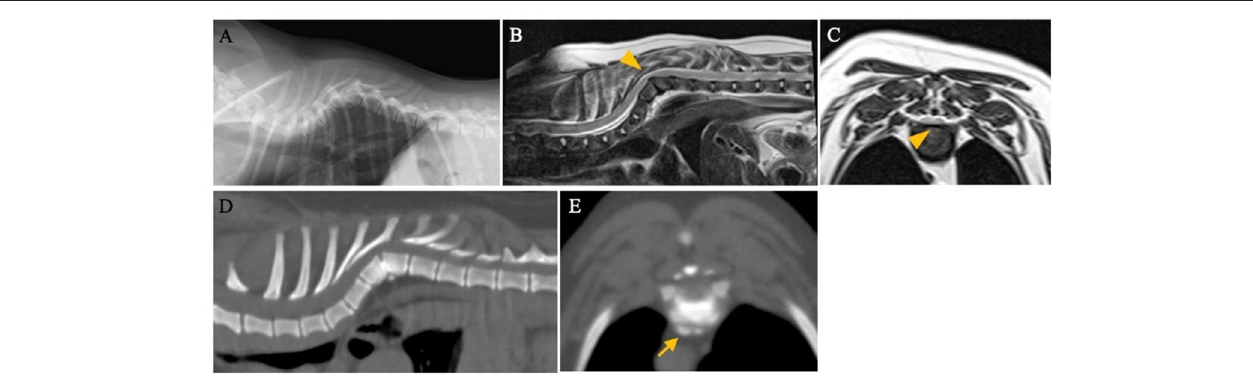
FIGURE 1 | Radiographic, computed tomography (CT), and magnetic resonance images of a 2-year-old dog with wobbly gait of the pelvic limbs. (A) Left-right lateral view. There was ventral hypoplasia of T6 and T7 with severe kyphosis. T2-weighted sagittal (B) and transverse (C) magnetic resonance images at the T6–T7 level. The spinal cord was severely compressed by the deformed vertebrae (arrowhead). (D,E) CT images showed sclerotic changes at the vertebral endplates of T6-T7 and the spondylosis deformans at the level of the T6–T7 disc